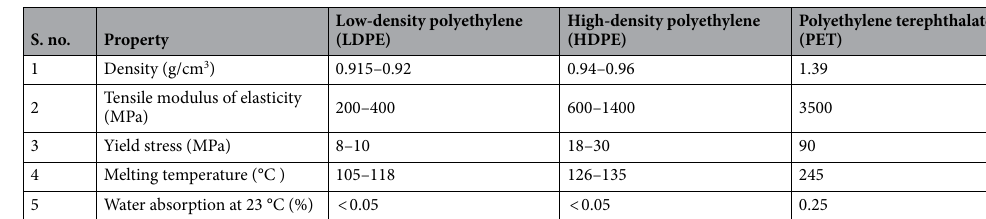
Table 3. Typical properties of the waste plastics.